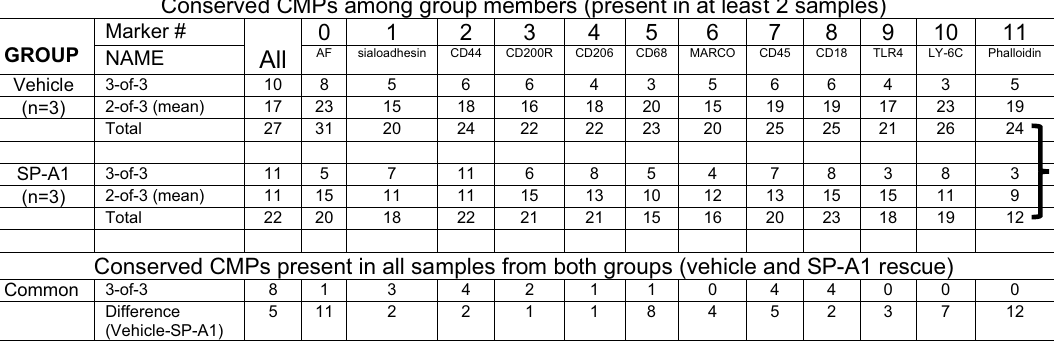
Conserved CMPs present in all samples from both groups (vehicle and SP-A1 rescue) Table 2. Conservation of CMPs among samples. In the whole image data, CMPs present in all 3 Vehicle samples (3-of-3) and all 3 SP-A1 rescue samples were tabulated, as well as CMPs that were present in 2 out of 3 of the samples (2-of-3) for each group. The total of the 3-of-3 and 2-of-3 is then given. These are referred to as “conserved CMPs.” The first data column (All) lists the CMPs present in the 54 most abundant CMPs for all 3 samples. Subsequent columns (labeled 0–11) compare CMPs that include the most abundant CMPs for each marker. For example, in the column labeled Marker 0, only the CMPs that included Marker 0 were compared. At the bottom of the table, the row labeled “Common” lists how many of the conserved CMPs are present in both Vehicle and SP-A1 rescue groups. Totals (3-of-3 plus 2-of-3) were compared (indicated by } ) by the Wilcoxon Rank Sum Test and found to differ significantly ( p < 0.0004). protein” 46,51 . Similar marker-specific data sets were generated for each of the markers and probed as described above to assess conservation of CMPs among group members. We counted CMPs that matched or were present in all three members of the groups (3-of-3), as well as CMPs that matched or were present in two out of the three members of the group (2-of-3), and refer to these as “conserved CMPs.” Table 2 shows the tabulated values for “All” and for each marker. We also recorded the sum of both the 3-of-3 and 2-of-3 CMPs (Total). For example, in the first data column (All) 10 of the 54 most abundant CMPs were found in all three members of the Vehicle group and 17 of the 54 most abundant CMPs were present in two of the three members. This gave a total of 27 CMPs out of the most abundant 54 that were well conserved among the Vehicle group members. The SP-A1 rescue group had 11 CMPs present in all three SP-A1 group members (3-of-3) and 11 present in 2-of-3 group members for a total of 22. The 2-of-3 numbers are derived from making 3 different pairwise comparisons among the three samples (i.e. sample #1 vs sample